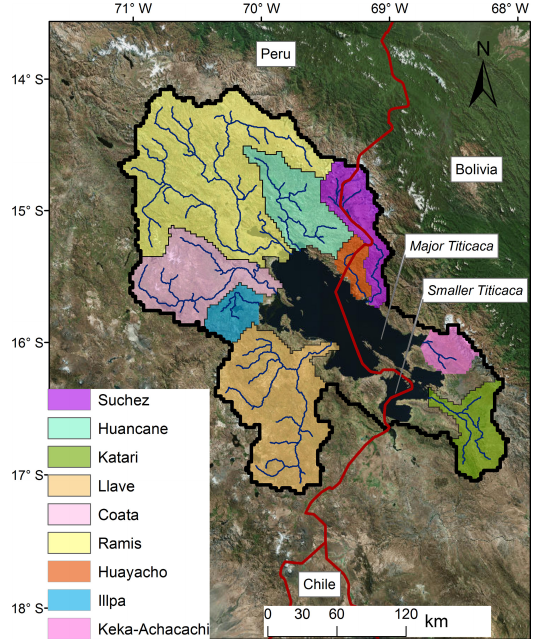
Figure 2. Lake Titicaca basin with sub-basins and major and smaller